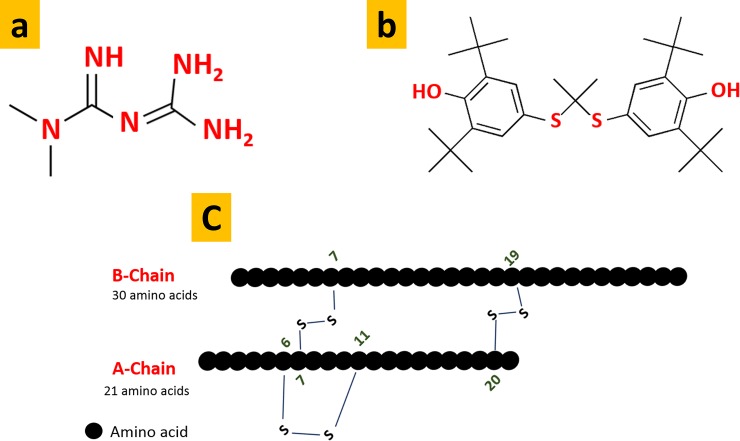
Chemical structures of metformin (a), probucol (b), and insulin (c).